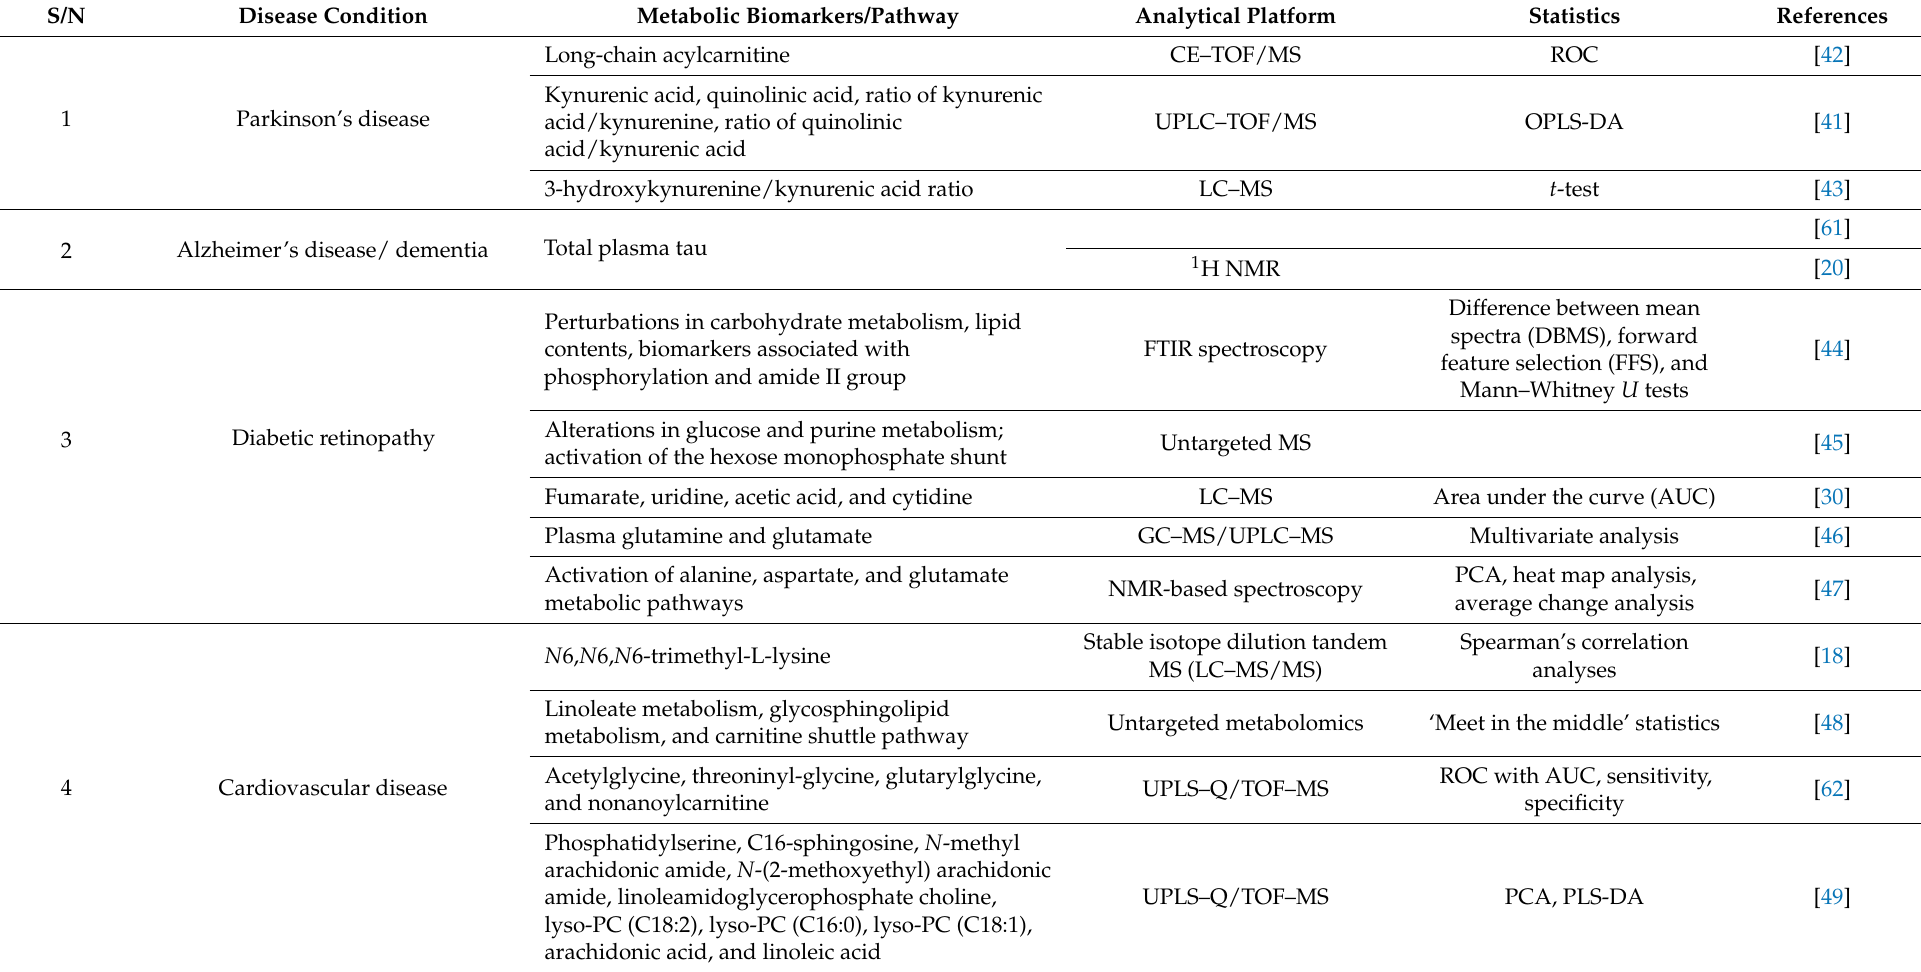
Table 2. A few metabolic biomarkers of diagnostic and prognostic